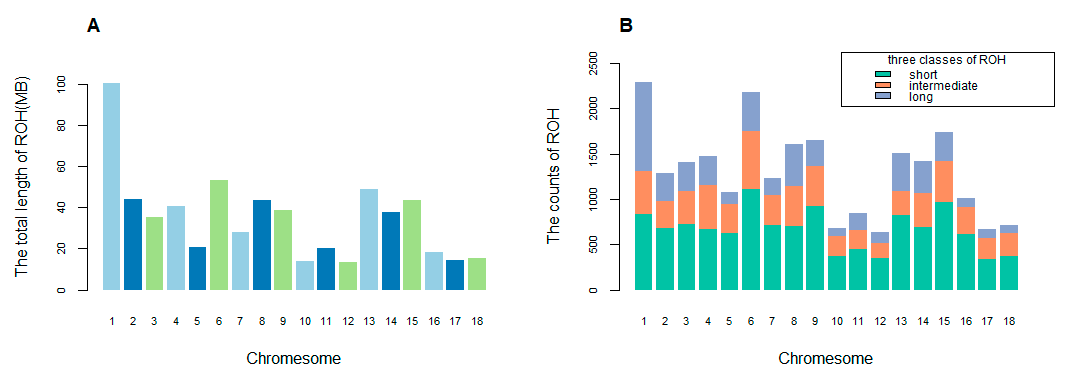
Figure 3. Distribution of ROH in each chromosome. ( A ) Total length of ROH on 18 autosomes. ( B ) Counts of three classes of ROH on 18 autosomes.